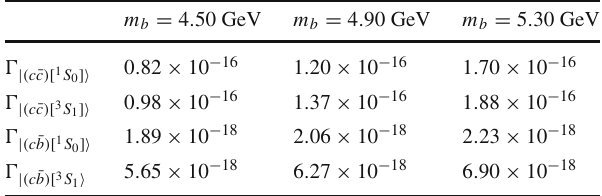
Table 3 Uncertainties of the decay width for the process t → | ( c ¯ Q ) [ n ](cid:5) + Q + Z 0 by varying m ∈ [ 4 . 50 , 5 . 30 ] GeV b m b = 4 . 50 GeV m b = 4 . 90 GeV m b = 5 . 30 GeV